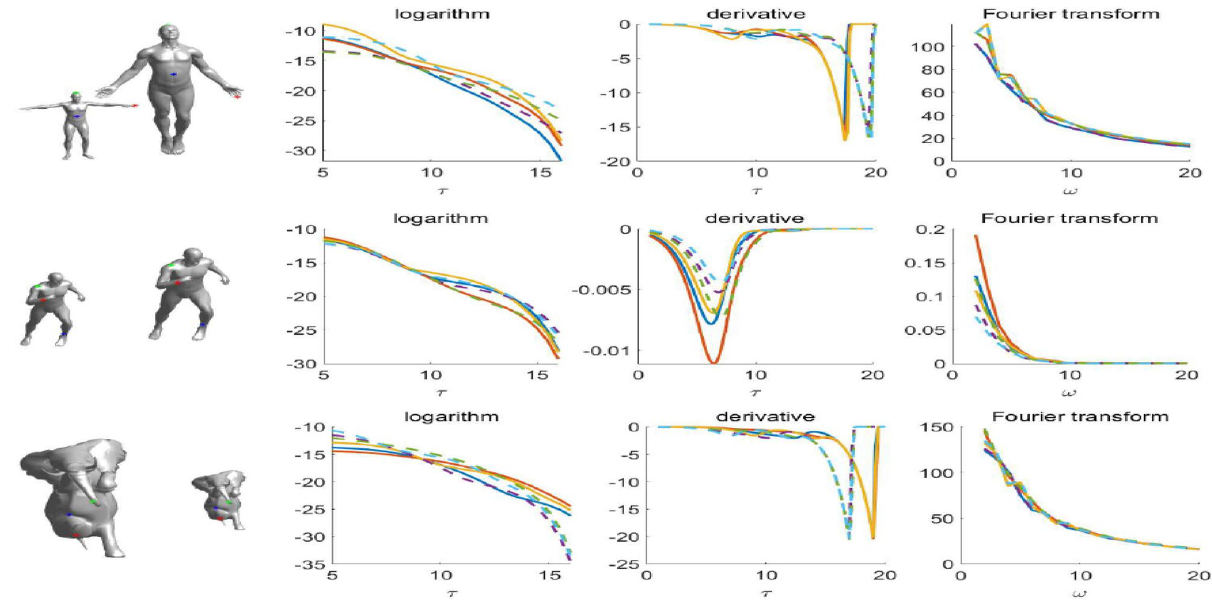
Figure 1. Construction results of the SIMHW descriptor: the point curve corresponding to the logarithm, derivative, and Fourier transform construction process from MHW to